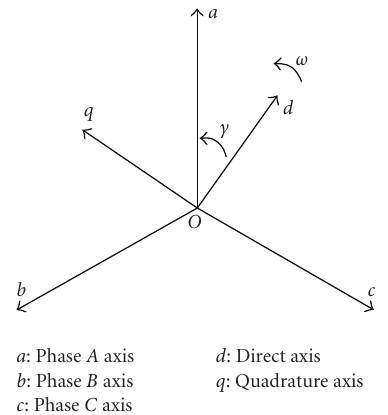
Figure 1: System of stator phase axes and the d - q reference